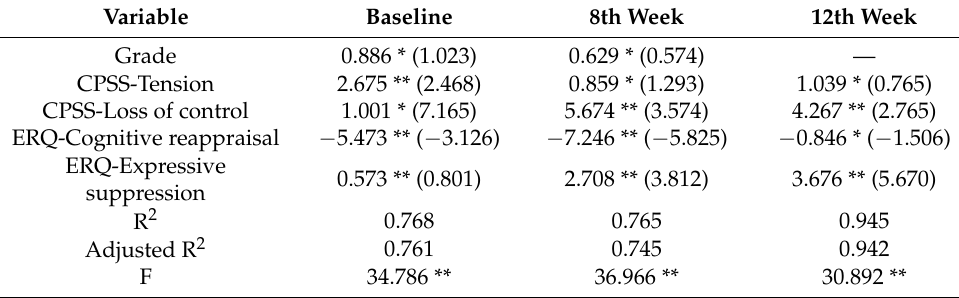
Table 8. Stepwise regression analysis results of MBSR